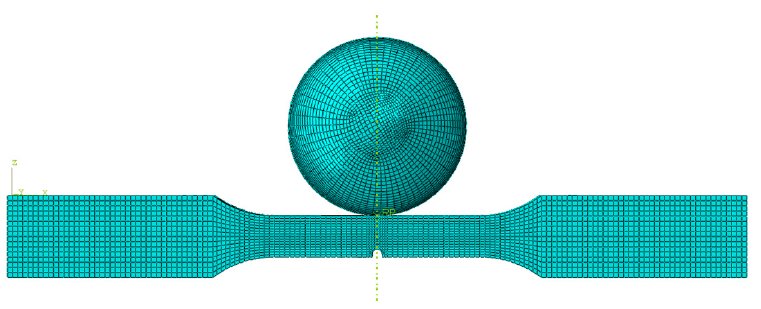
Figure 6. Finite element model of dissimilar lightweight materials welded joint and rigid ball for the impact process.